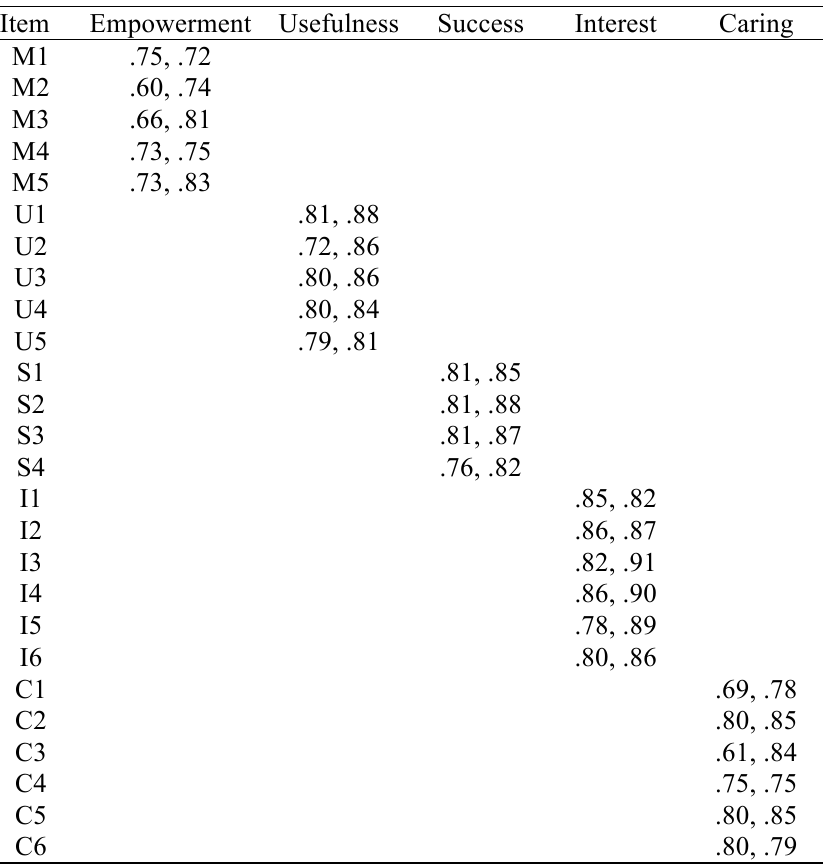
Standardized Factor Loadings from the